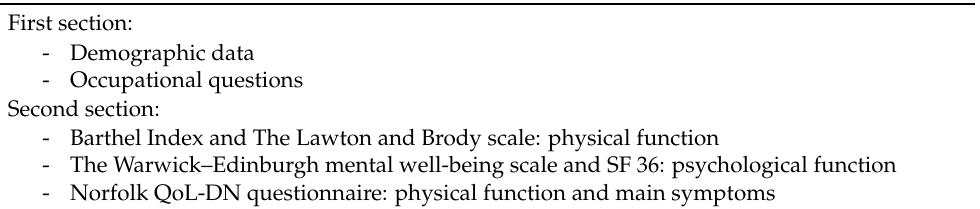
Table 2. Semi-structured interview